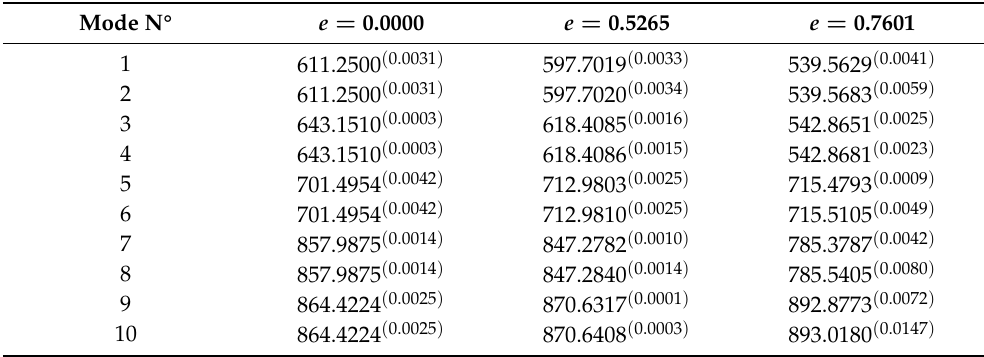
Table 2. Natural frequencies ω (rad/s) for elliptical shells with different eccentricities e . Subscript: percent difference against ref. [49].